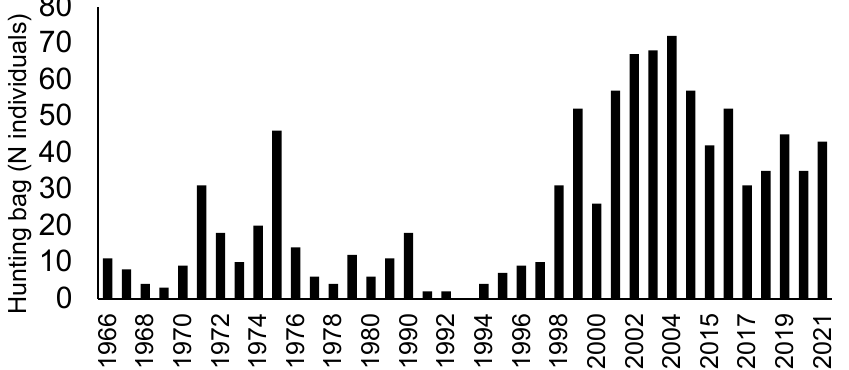
Figure 3. Hunting bag of the red fox in the study area (data from the Experimental Forest Station in Rogów, Forest Data Bank—Hunting Reports).